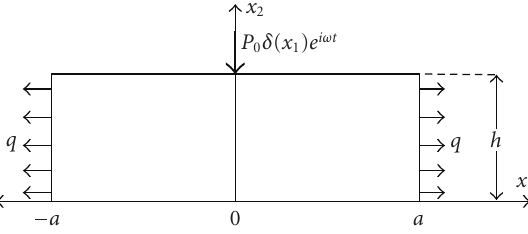
Figure 2.1 . The geometry of the strip plate resting on a rigid